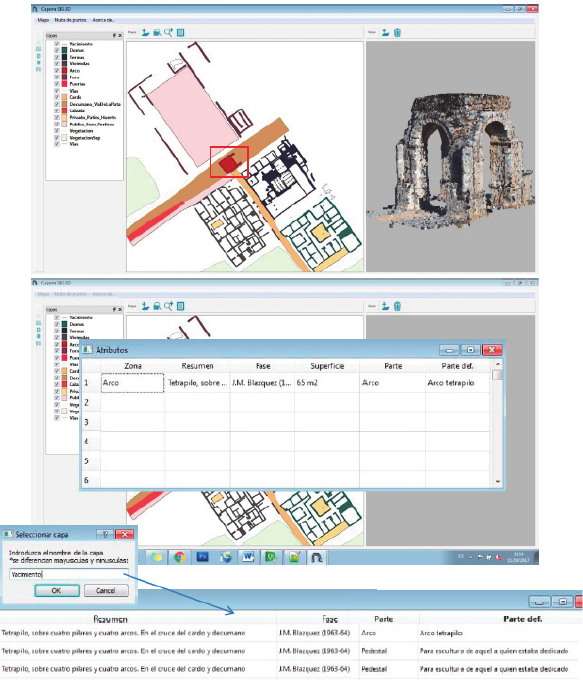
Figure 8. Example of the viewer, and the addition of attributes to the geodatabase.